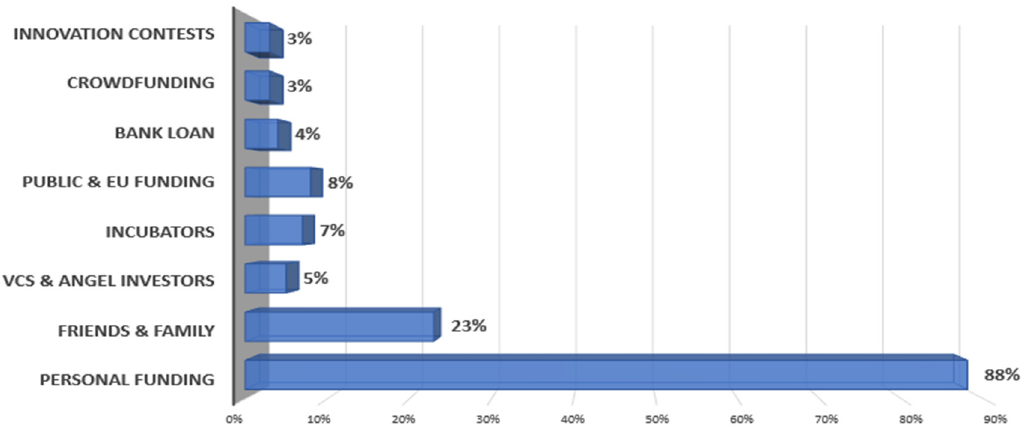
Figure 4. Funding sources of Greek start-ups.